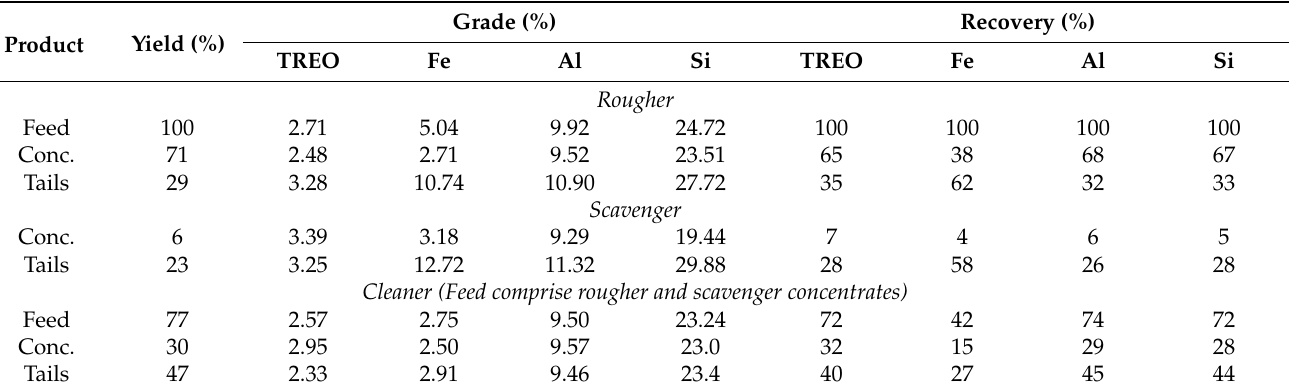
Table 6. Summary of results obtained for Flowsheet III at pH